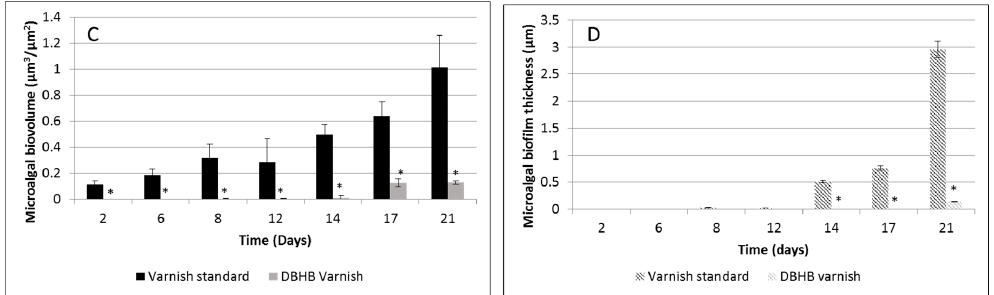
Figure 8. Biofilm quantification on varnishes during in vitro immersion. Bacterial and microalgal biovolumes ( A , C ) and biofilm thicknesses ( B , D ) were determining during 21 days after COMSTAT analysis of CLSM observations. Data represent the mean ± standard deviation of replicates; * statistically significant difference at the 95% confidence level between standard (varnish without DBHB) and varnish containing DBHB.